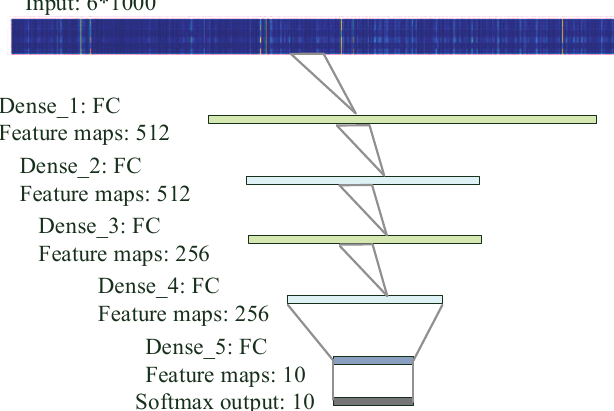
Figure 7. MultiLayer Perceptron (MLP) architecture to decode silent speech. A feature vector goes through the layers and a digital (from 0 to 9) will be output.